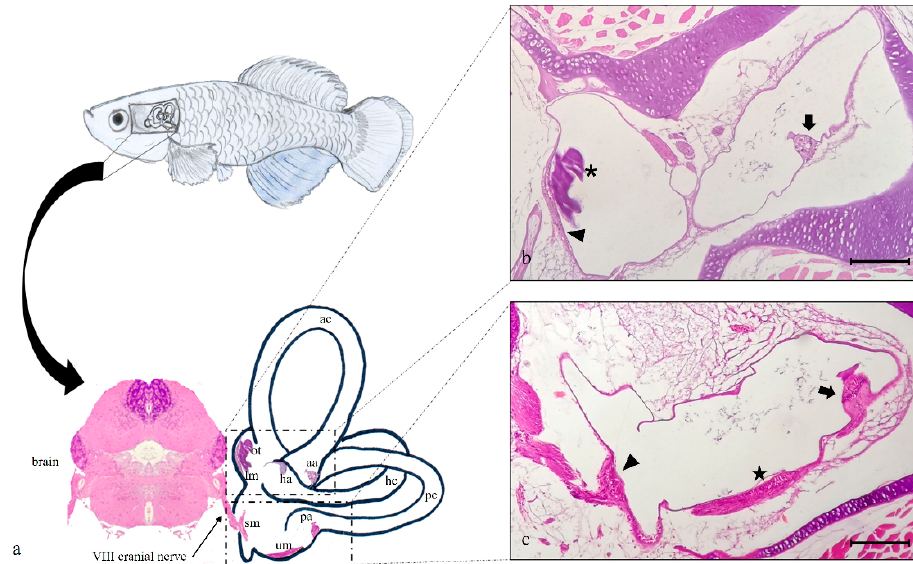
Figure 1. (a) graphical representation of N. guentheri inner ear that includes the three semicircular canals: anterior (ac), horizontal (hc), and posterior (pc) with their respective crista ampullaris (aa, ha, pa). Furthermore, the horizontal canal contains the macula of lagena (ml) and otholith (ot), while the posterior canal contains saccular macula (sm) and utricular macula (um). The brain from which branches off the VIII° cranial nerve that innervates the saccular macula of the posterior canal in the inner ear is shown. (b) Light micrographs (H&E): transversal view, the semicircular anterior canal (ac) of the inner ear, with crista ampullaris (arrow). Semicircular horizontal canal (hc) of the inner ear with macula of lagena (arrowhead) and otolith (asterisk). (c) Light micrographs (H&E); transversal view, the semicircular posterior canal (pc) of the inner ear, with crista ampullaris (arrow), sacculus macula (arrowhead), and utricular macula (star). Magnification 10X (b,c). Scale bars 200µm (b,c).